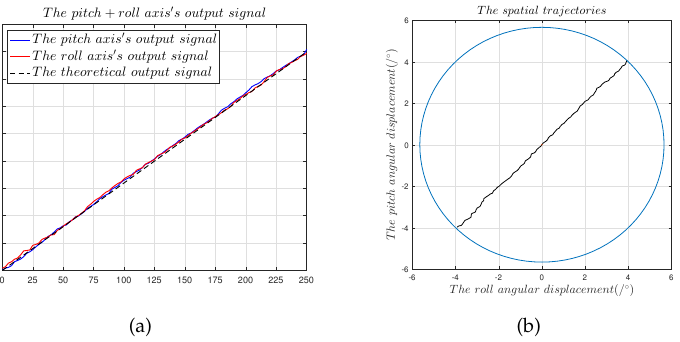
Figure 21. Dual-axis compensation experiments in the 45° direction: ( a ) compensation results of the angular displacement signals α 1 and α 2 ; ( b ) 45° displacement trajectories fitted by α 1 and α 2 .